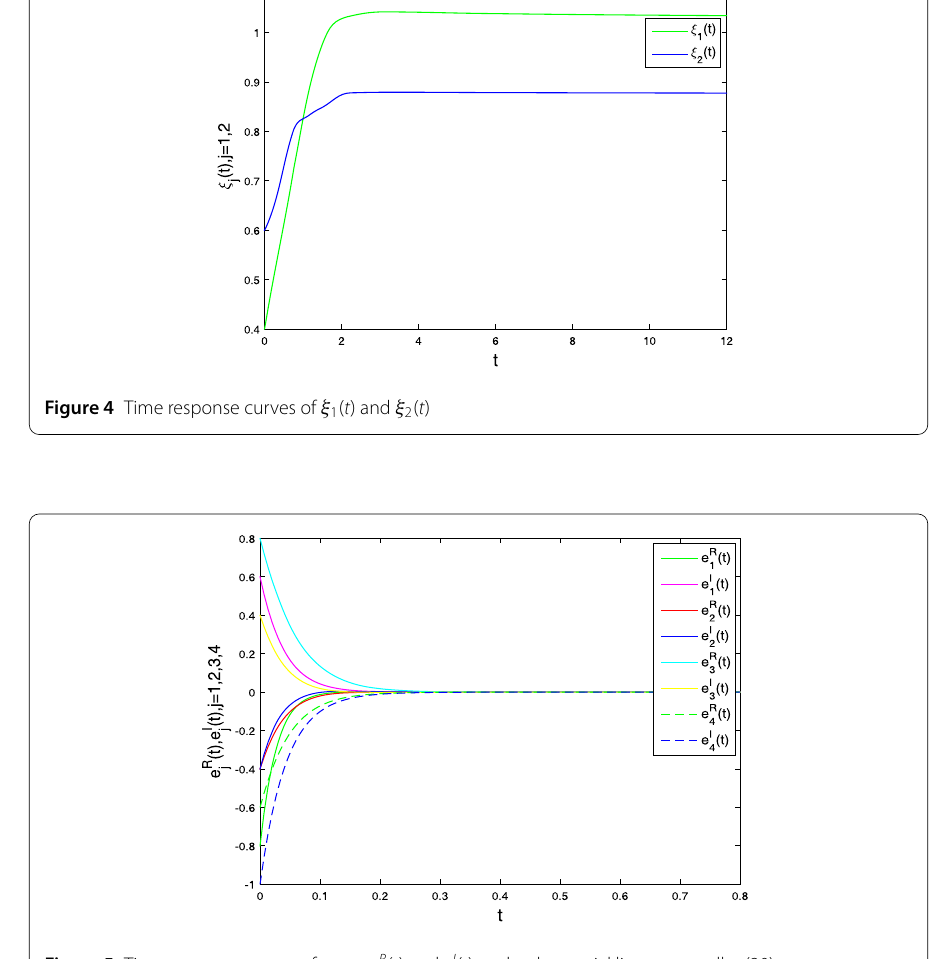
Figure 5 Time response curves of errors e R j ( t ) and e I j ( t ) under the partial linear controller